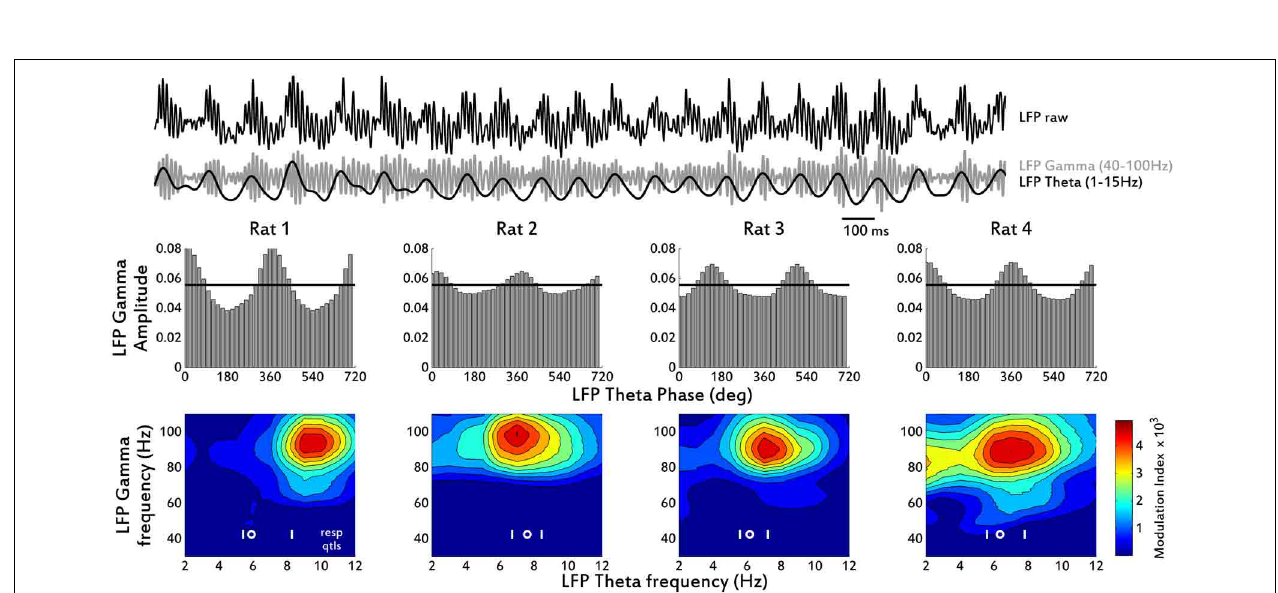
respiratory cycles. Red color indicates values greater than zero. (B) Inhalation-triggered LFP mean for data in (A) . (C) Inhalation-triggered LFP means for data of respiratory frequencies between (4–12Hz), showing one trace per rat.